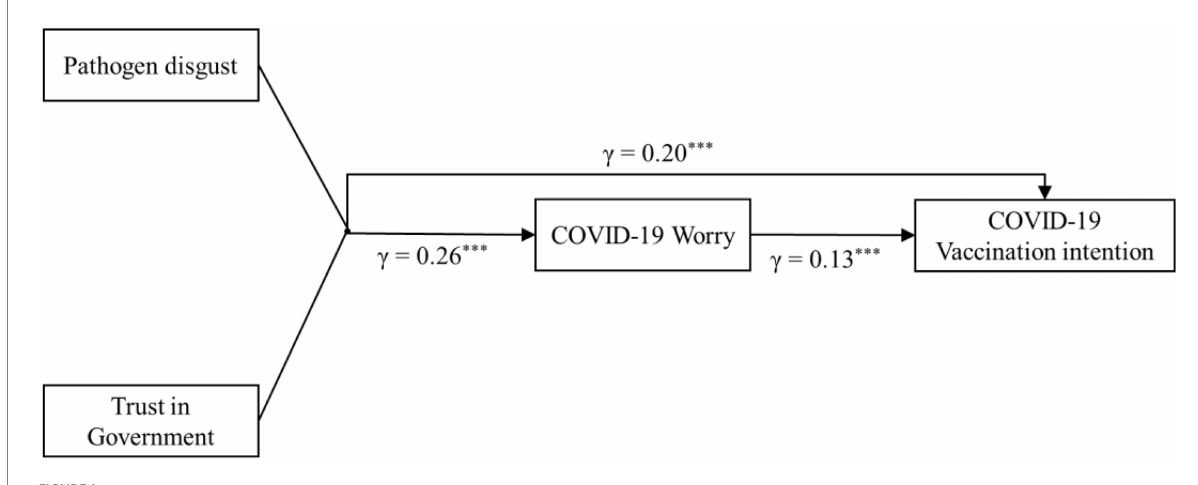
FIGURE 1 Mediation